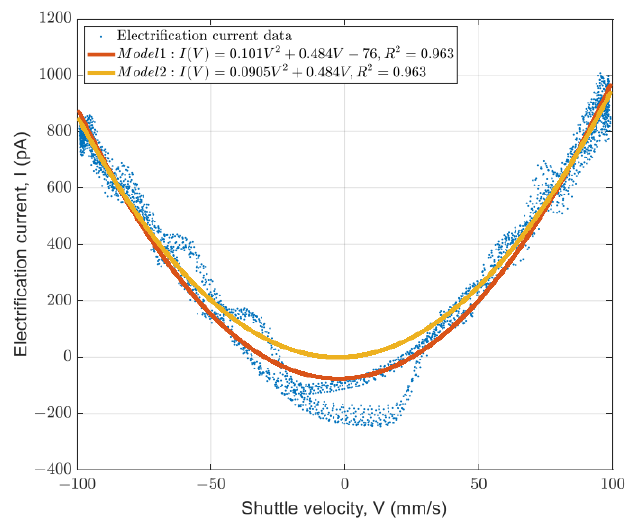
Figure 16. Dependence of electrification on intermittent shuttle speed and fitted second order polynomial models. Shuttle frequency is 2